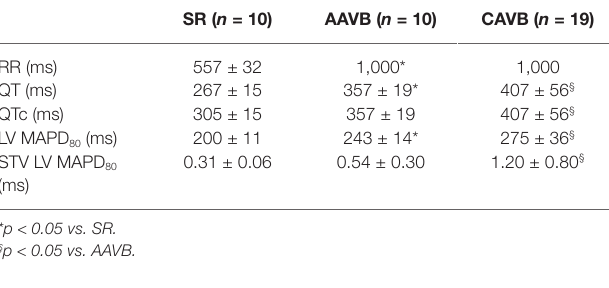
TABLE 1 | Baseline electrophysiological parameters.